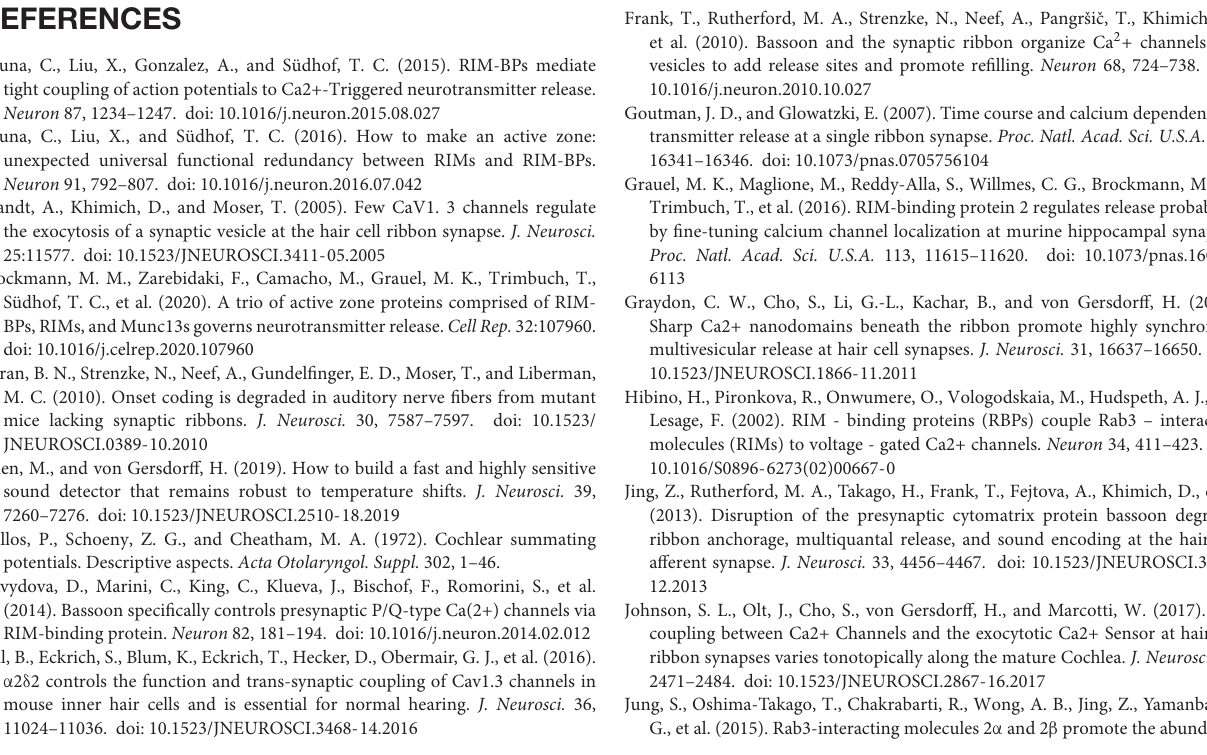
Supplementary Figure 2 | RNA Analysis of RIM-BP1 expression in the organ of Corti. Maximum projection of confocal stack after RNAscope experiment and consecutive immunohistochemistry from apical organ of Corti whole-mount explant from 2-week-old C57BL/6 mouse. Calretinin [ (B) , blue in merge image (A) ] marks IHCs. Otoferlin RNAscope probe [ (C) , magenta in merge image (A) ] was used as positive control. Otoferlin mRNA is present in IHCs, mainly localized around the IHC nuclei. RIM-BP1 mRNA could not be detected by the RNAscope probe [ (D) , green in merge image (A) ]. Scale bar: 10 µ m. Supplementary Figure 3 | RIM-BP1 is expressed in the mouse organ of Corti. Nested RT-PCR from organs of Corti, brain, and 10 individual IHCs from 2-week-old C57Bl/6 mice. In the negative control cDNA was omitted from the reaction. Nested PCR primers were specific for RIM-BP1 (A) or RIM-BP2 (B) cDNA. The following DNA bands were expected: 196 bp for RIM-BP1 (A) , 408 bp for RIM-BP2 (B) . Both RIM-BPs were detected in brain tissue. RIM-BP2